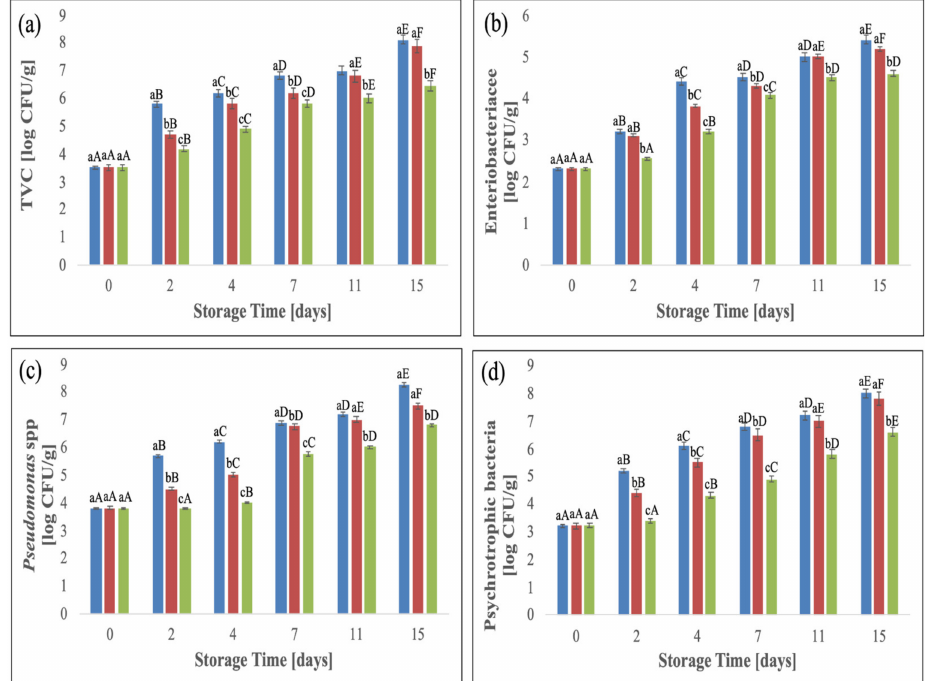
Figure 4. Changes in total viable bacterial count ( a ), Enterobacteriaceae ( b ), Pseudomonas spp. ( c ) and psychrotrophic bacteria count ( d ) of pork meat samples during the storage time at 4 ◦ C. Different letters (a, b, c, . . . ) reveal significant differences ( p < 0.05) among the samples for each storage time, and different letters (A, B, C, . . . ) reveals significant differences ( p < 0.05) for each treatment during the storage